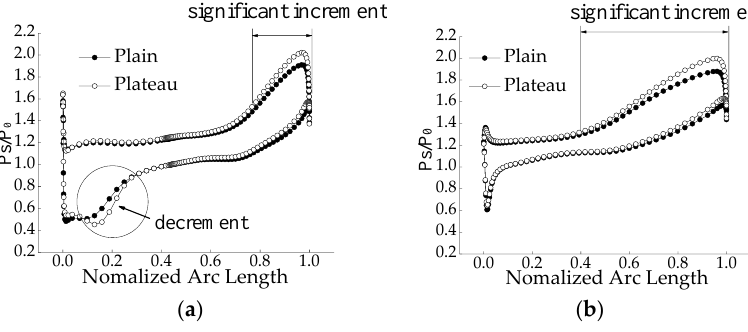
Figure 13. Load distribution of blade surface at 90% blade span: ( a ) main blade; ( b ) splitter blade. According to the analysis above, the main blade load is more sensitive to the altitude, and has